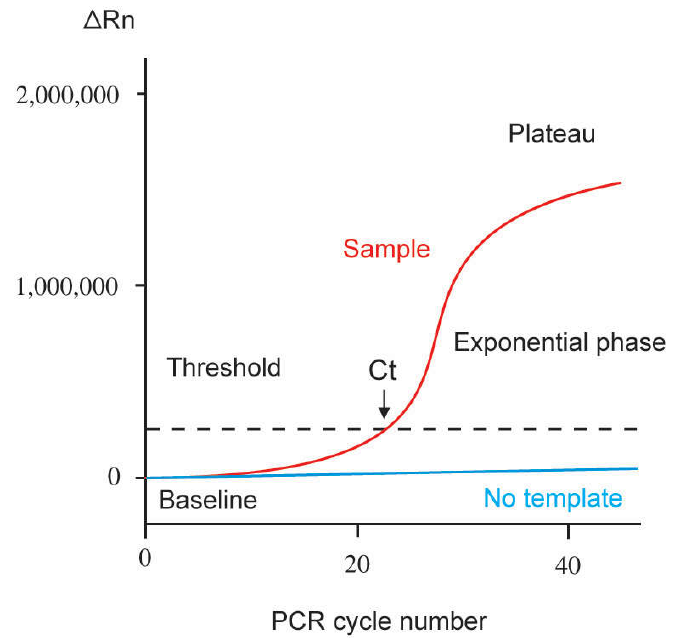
Figure 1. Representation of a single amplification plot of real-time quantitative PCR. ∆Rn = fluo- rescence emission of the amplicon at each time point minus fluorescence emission of the baseline. Ct = threshold cycle. Baseline refers to the PCR cycles in which the fluorescent signal of a reporter accumulates. However, it is below the limits of detection of the instrument (adapted from Arya et al. [5]).